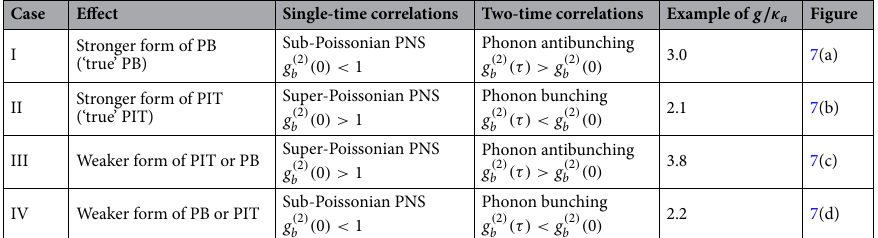
Case Effect Single-time correlations Two-time correlations Example of g /κ a Figure I Stronger form of PB (‘true’